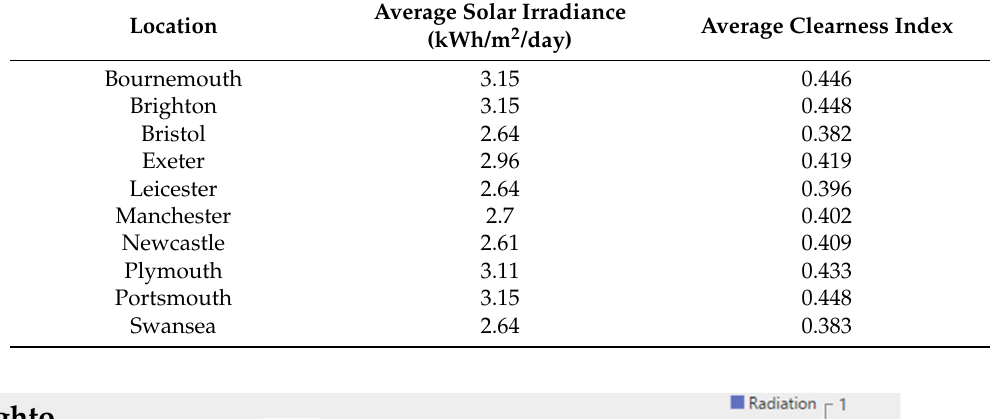
Table 3. Solar irradiance and clearness index values.